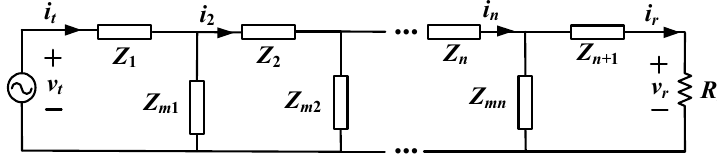
Figure 5. T-type equivalent circuit of the N-coil WPT system.